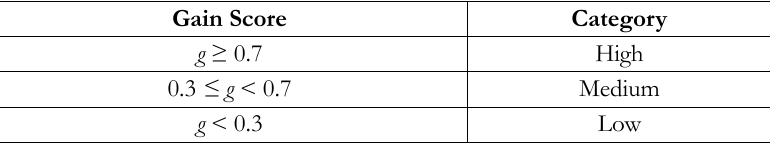
Table 4. Criteria of gain